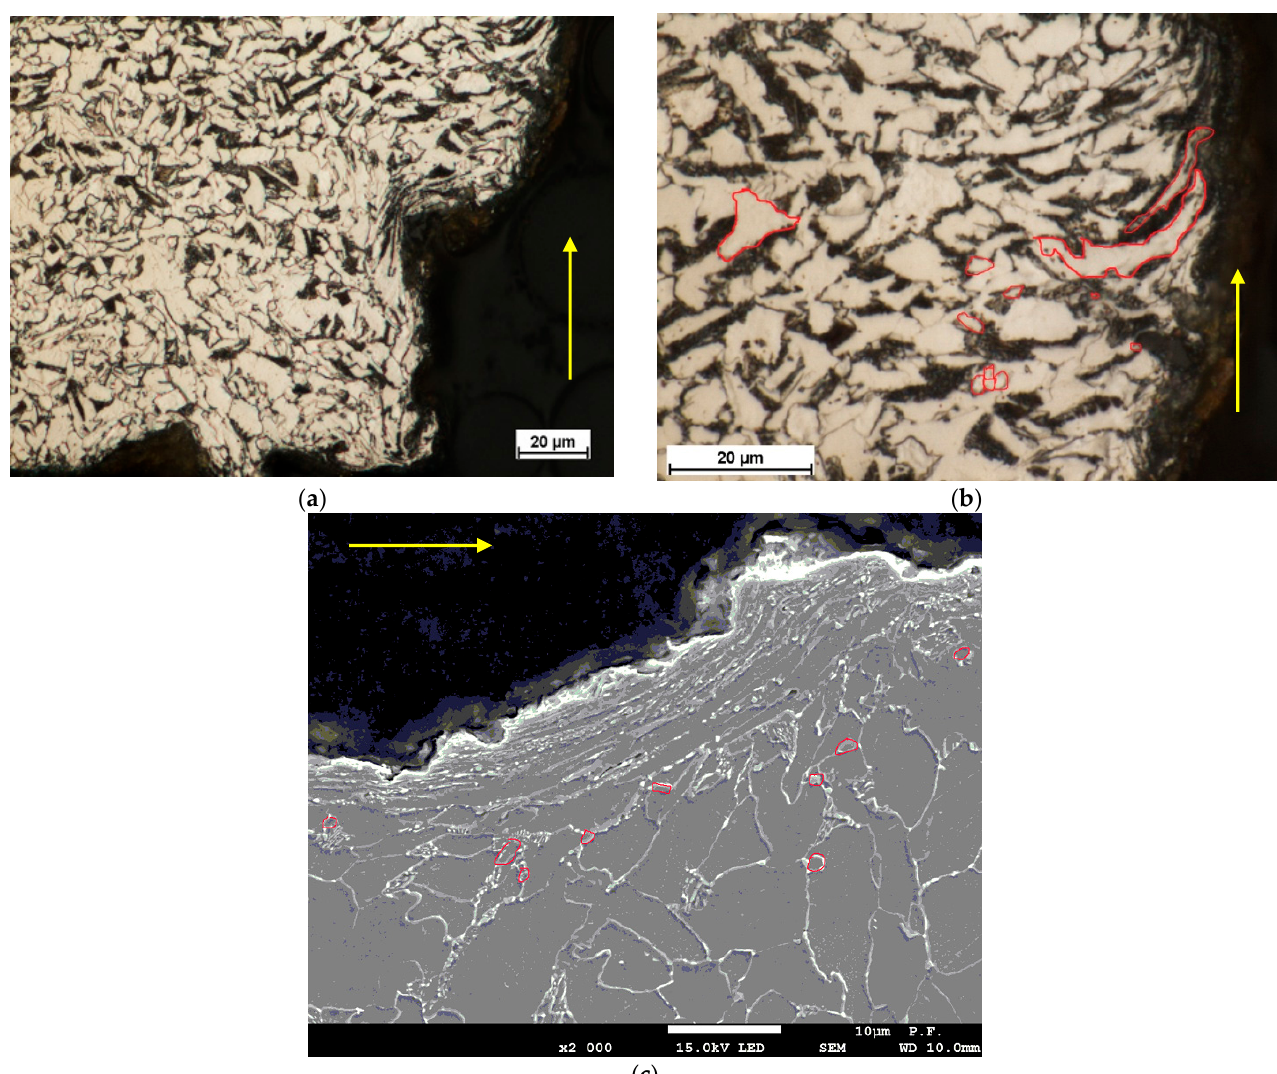
Figure 7. Metallographic microstructure of the cross-sectional area of cut produced at a low-power density of the jet — a pressure of 300 MPa and a cutting speed of 350mm/min. ( a ) water jet entry zone, ( b , c ) middle zone, circled in red new fine ferrite grains (after recrystallization) and deformed elongated grains).